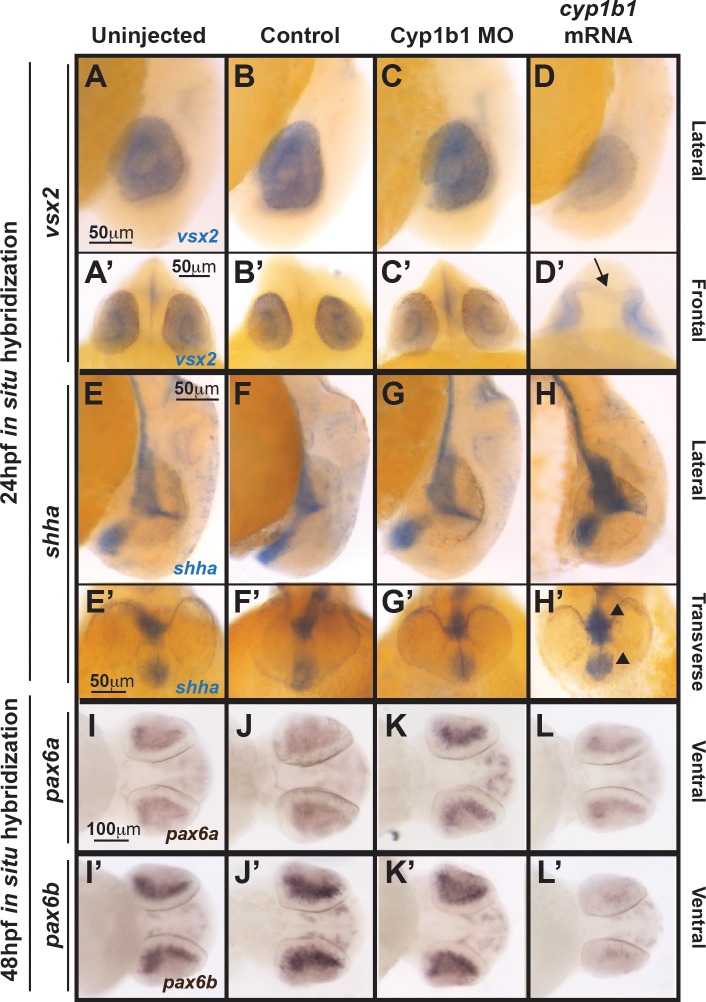
Cyp1b1 differentially regulated vsx2, shh, and pax6. Whole-mount in situ hybridization at 24 hpf demonstrated that vsx2 expression in the eye decreased in response to cyp1b1 overexpression (D, D') compared with Cyp1b1 MO knockdown (C, C'), control-injected (B, B'), and uninjected (A, A'') embryos. Note the appearance of tissue bridging the two optic cups in the cyp1b1 mRNA-injected embryo, as demarcated by vsx2 (arrow). Shha at 24 hpf showed increased expression in the midline floor plate between the eyes in embryos injected with cyp1b1 mRNA (arrowheads, H, H') compared with Cyp1b1 MO knockdown (G, G'), control -injected (F, F'), and uninjected (E, D') embryos. Pax6a and pax6b expression in the retina at 48 hpf decreased in response to cypb1 overexpression (L, L') compared with Cyp1b1 knockdown (K, K'), control-injected (J, J'), and uninjected (I, I') embryos.